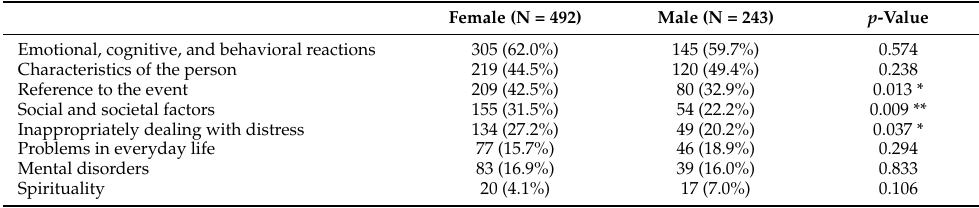
Table 4. Percentage of participants mentioning the second-order theme according to the thematic analysis presented by gender. p -values for gender differences were calculated with Fisher’s exact test.